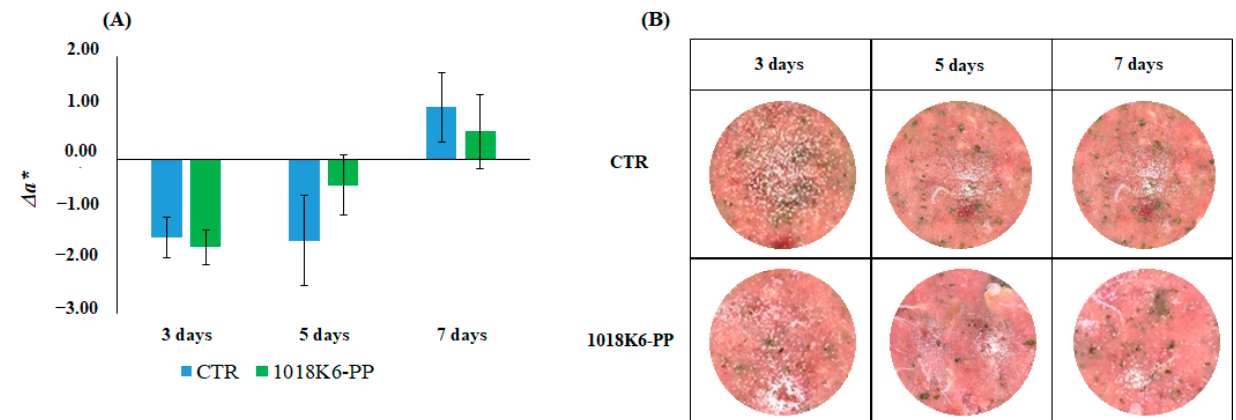
Figure 7. ( A ) Analysis of a* variation ( Δ a* ) in bonito fish burgers during the storage period. Results are means of three independent experiments and error bars represent the standard error (sem). CTR (blue)—PP films without 1018K6; 1018K6-PP (green)—PP films functionalized with 1018K6. ( B ) Photos of Sarda sarda burgers packaged with the control and functionalized slides at each sampling time.